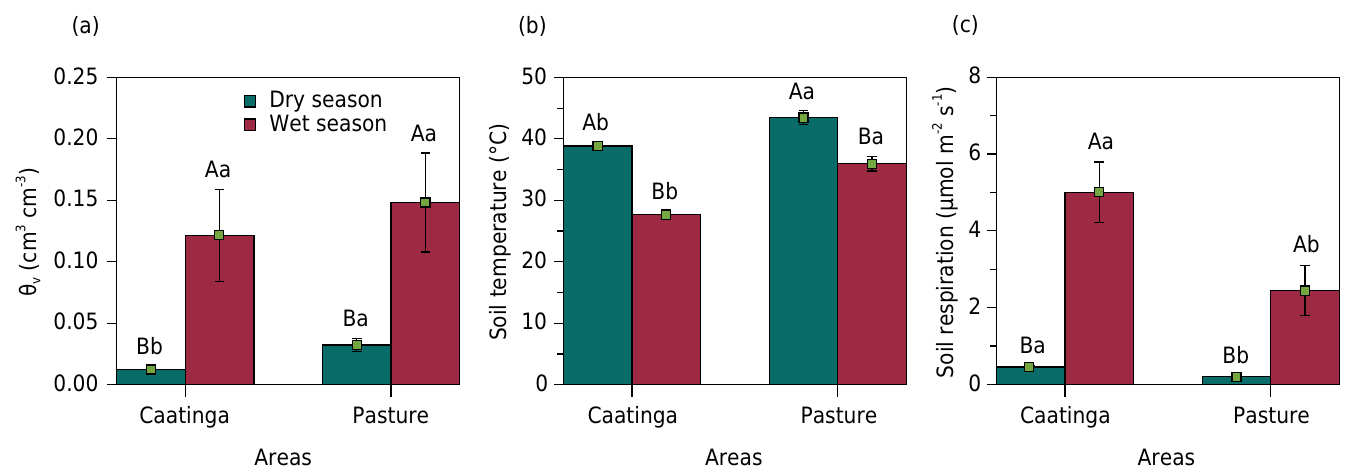
Figure 4. Comparison of soil water content, temperature, and soil respiration between seasons (dry and wet) and between areas. Uppercase letters compare the same area between seasons (dry and wet) while lowercase letters compare the different areas to the same season. Equal letters do not differ statistically at the 95 % confidence level according to the